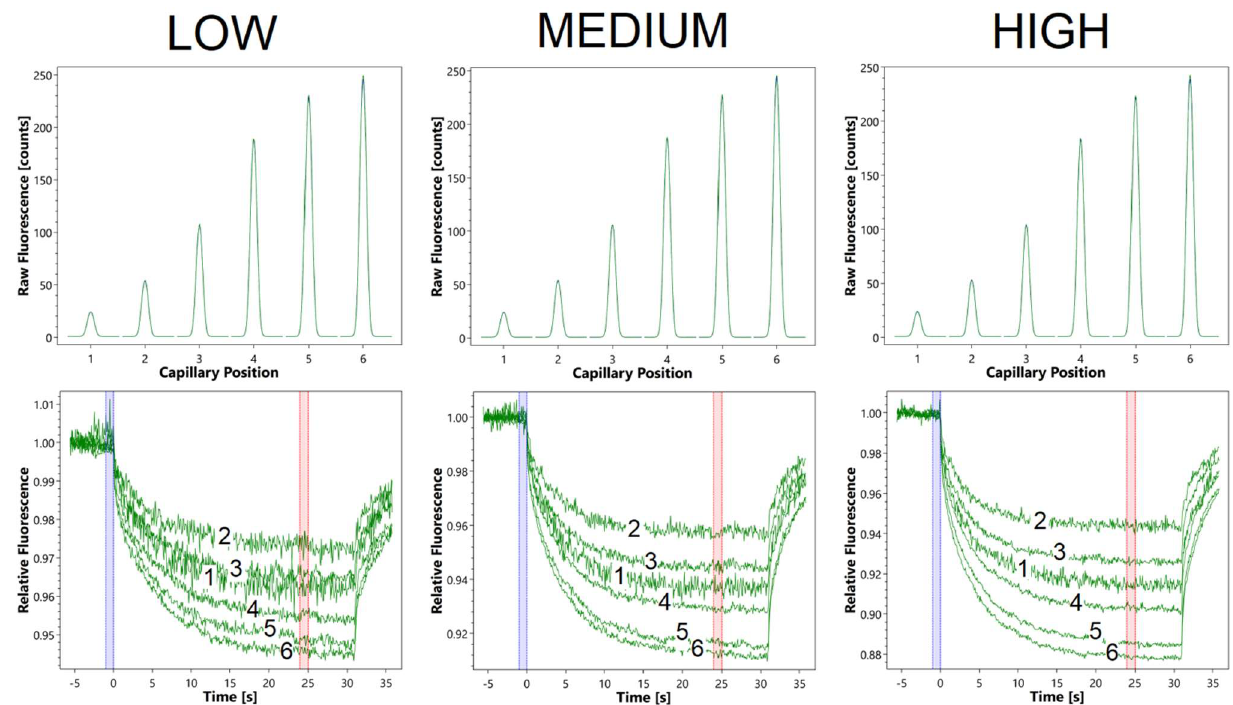
Figure 2. Data collected during the FITC analysis using the MST instrument; ( top )—initial fluores- cence intensity before turning on the IR laser for buffers with different pH: 1-pH 5.38, 2-pH 5.86, 3-pH 6.52, 4-pH 7.12, 5-pH 7.80, 6-pH 9.42; ( bottom )—change of fluorescence over time from turning on the IR laser depending on pH, in the same buffers, with different IR laser powers: low, medium and high. The blue and red bars indicate the data used to calculate the MST response—a quantitative parameter for the further analysis (p K a determination).